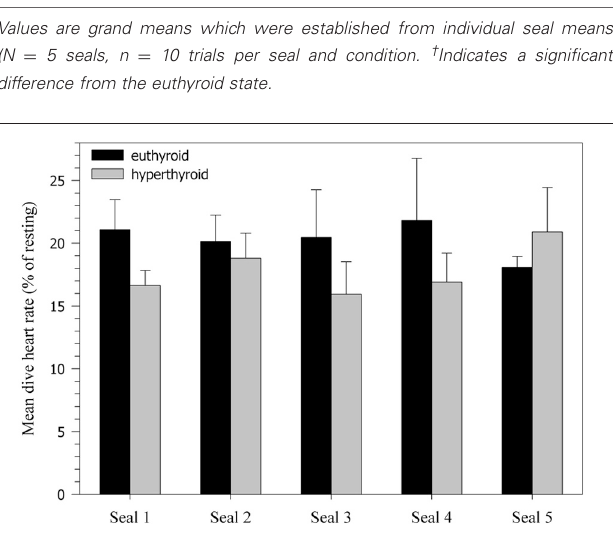
FIGURE 4 | Heart rate decline during 5min dives (% of resting heart rate). Values are means ± SD ( N = 5 seals, n = 10 trials per seal and condition).